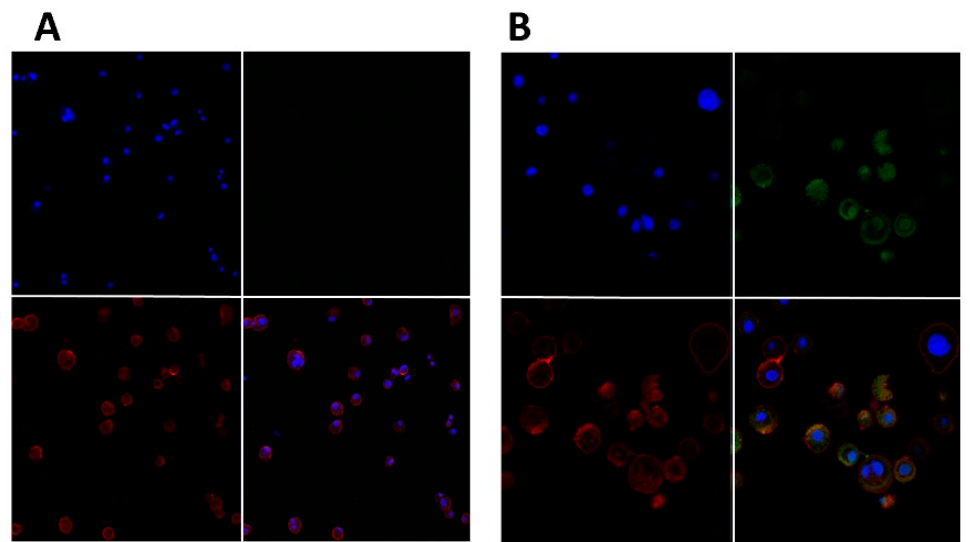
Figure 7. Confocal microscopy images of hybrid cationic CHL NPs uptake by DCs after 1 h incubation. DCs incubated without hybrid cationic CHL NPs at 20× ( A ), DCs incubated with hybrid cationic CHL NPs at 63× ( B ). Red channel for WGA TR: cell membrane, blue channel for DAPI: nucleus, and green channel for FITC-BSA: hybrid cationic CHL NPs incorporating FITC-BSA.